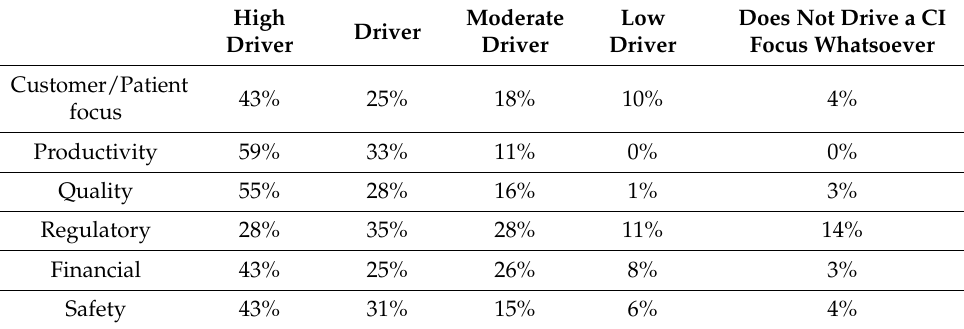
Table 3. Internal drivers of CI in the Irish pharmaceutical industry by focus